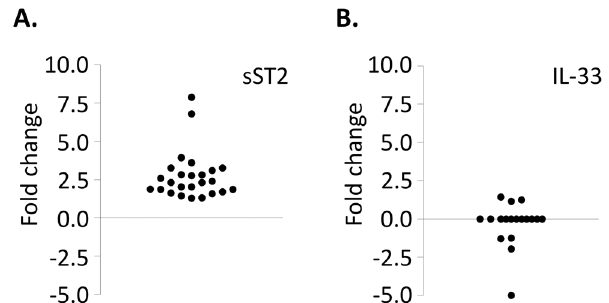
Figure 1. sST2, but not IL-33, is increased in human FFs compared to plasma levels. FFs (at least 5 per patient) and plasma samples were collected from 21 women undergoing ART. Levels of sST2 and IL-33 were determined by ELISA. The mean values of FF levels were compared to the plasma levels, and the fold change in sST2 (A) and IL- 33 (B) displayed.